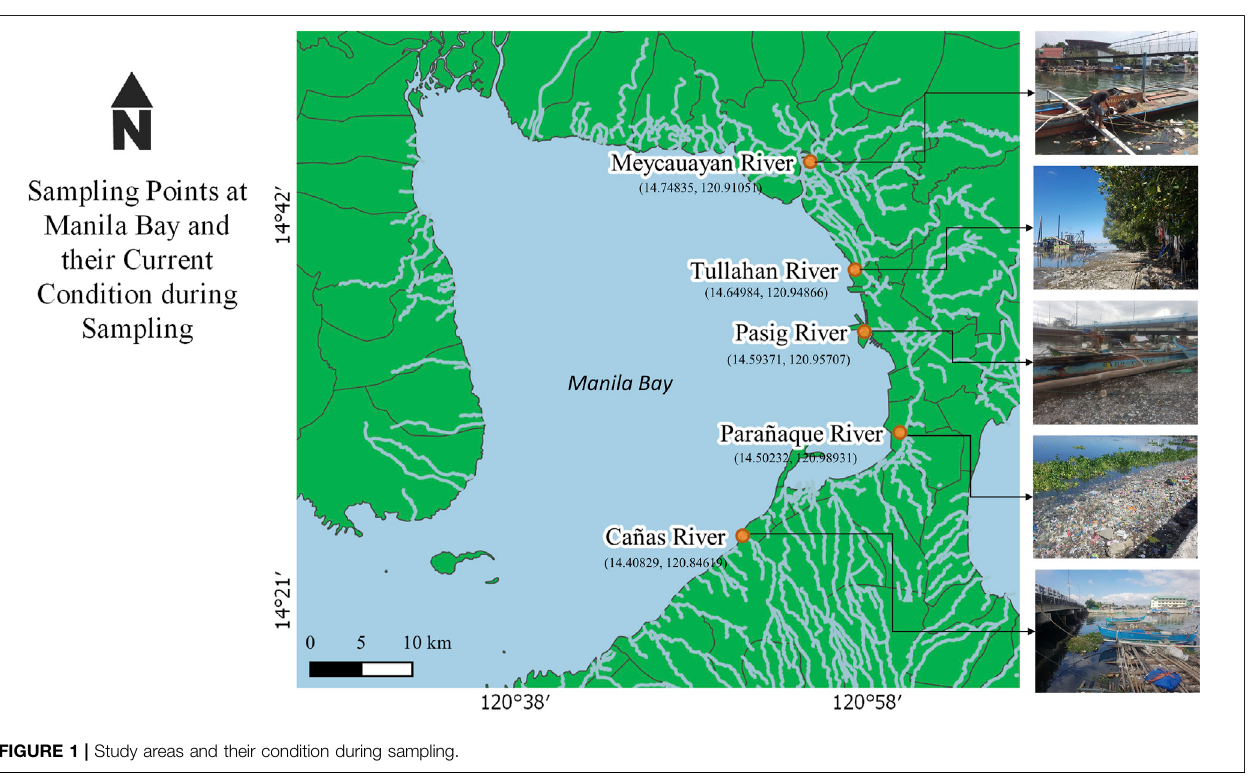
FIGURE 1 | Study areas and their condition during sampling.